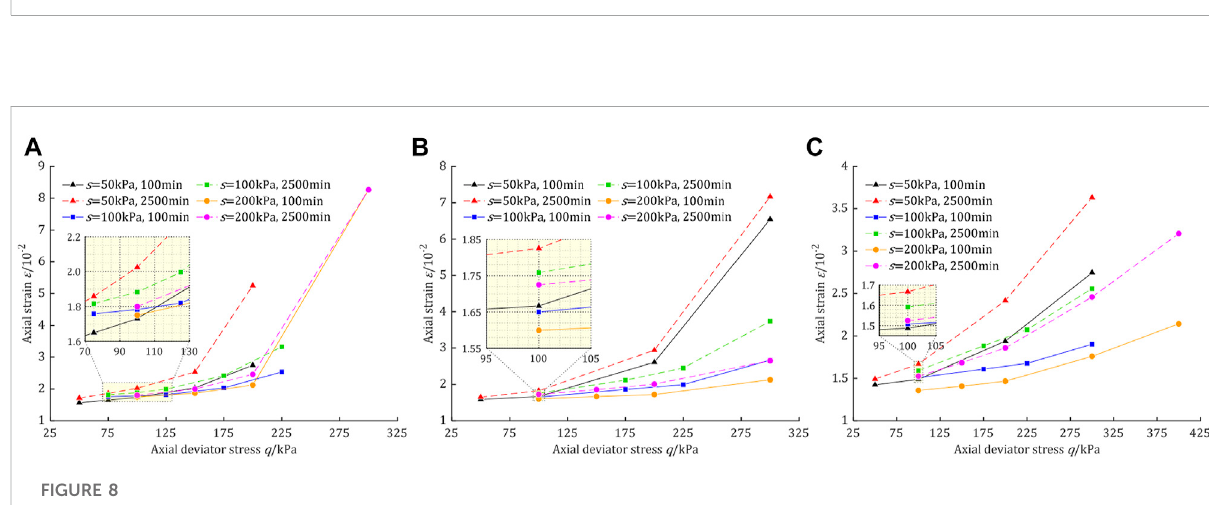
FIGURE 8 The isochronous stress-strain curves under different matric suctions. (A) σ 3-ua=50kPa; (B) σ 3-ua=100kPa; (C) σ 3-ua=200 kPa.